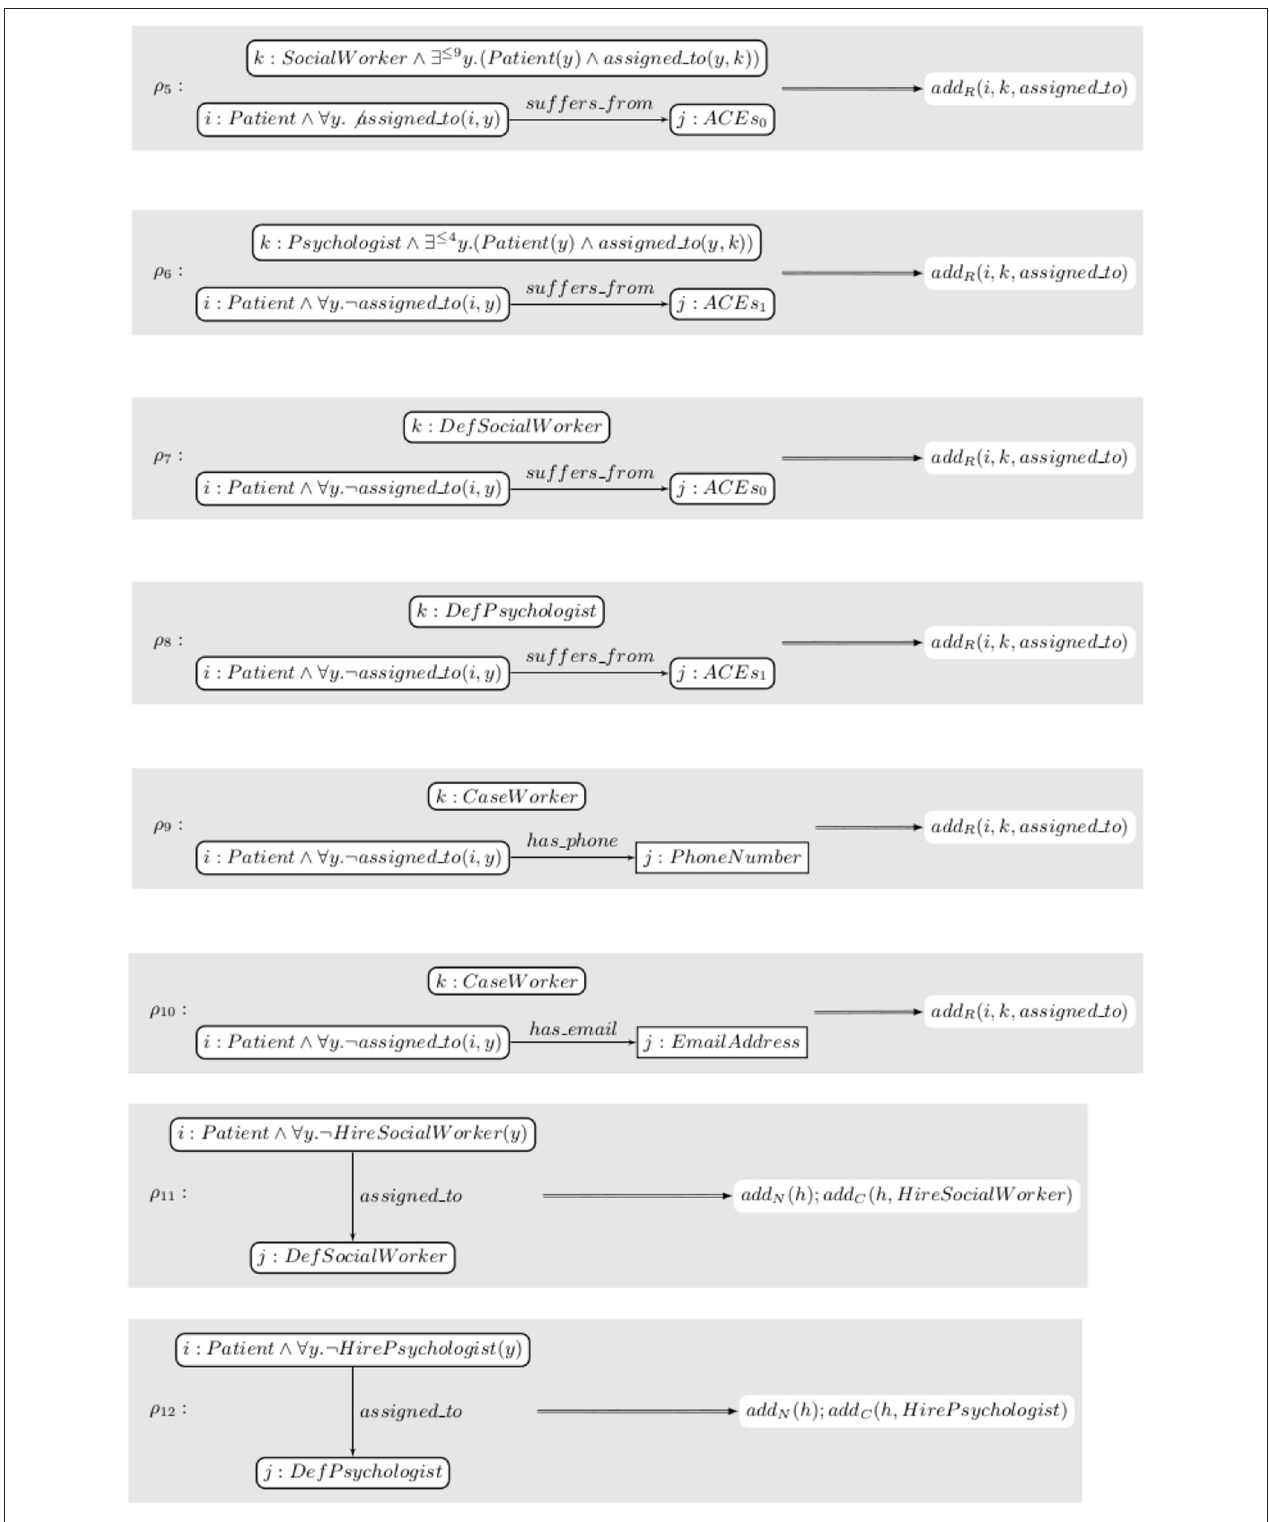
FIGURE 9 | The rules used in Example